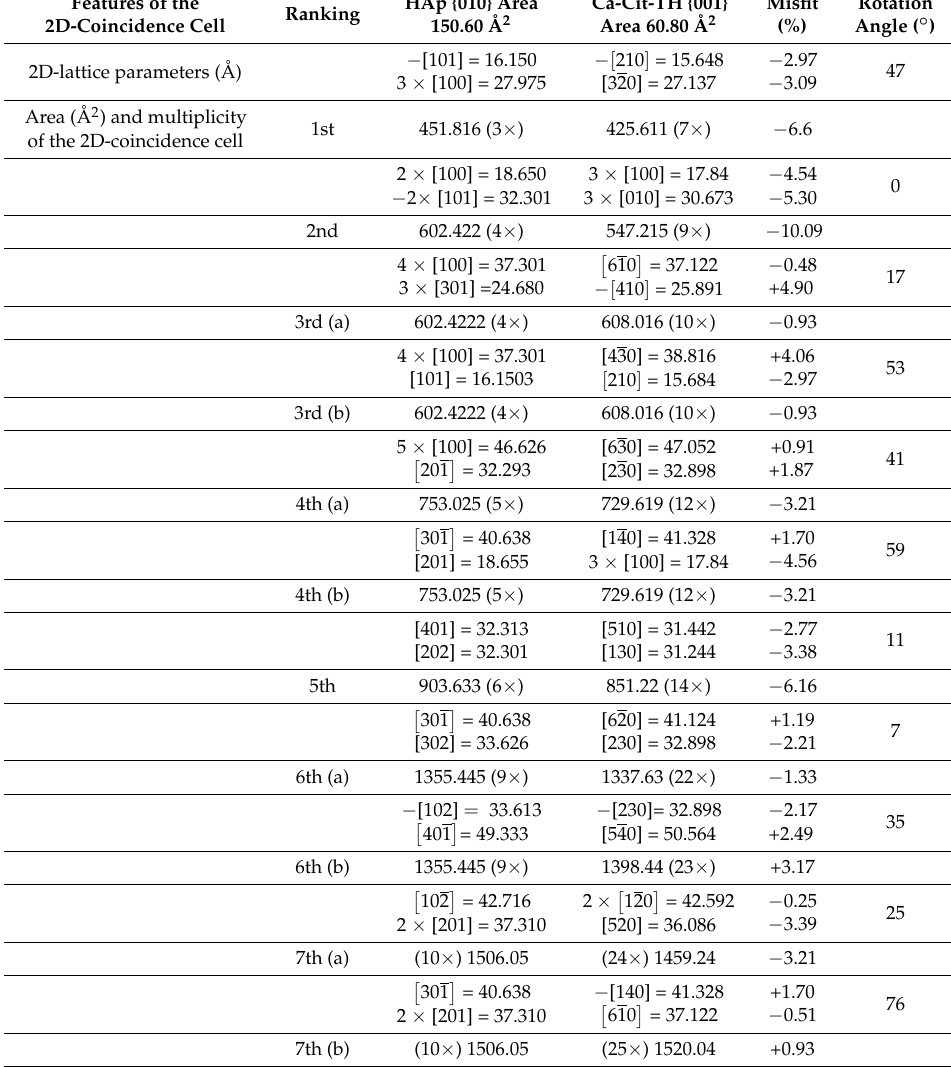
Table 3. 2D-coincidence lattices between the {010}-HAp form and the {001} form of Ca-Cit-TH. Rotation angle refers to the angle formed between the vectors [100] of both the involved 2D